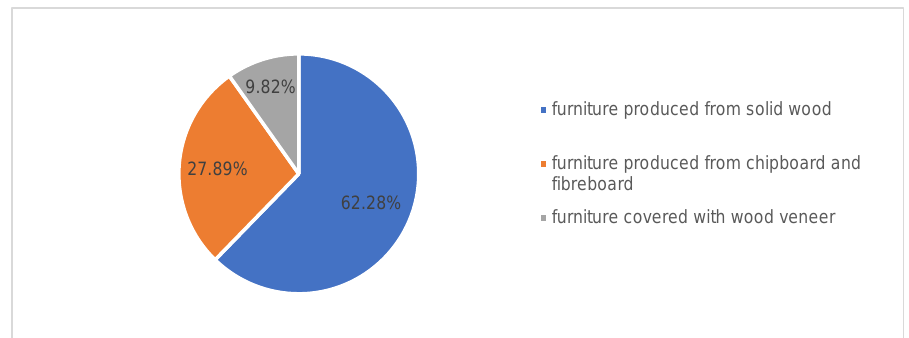
Figure 5. Preferred material for the production of furniture.